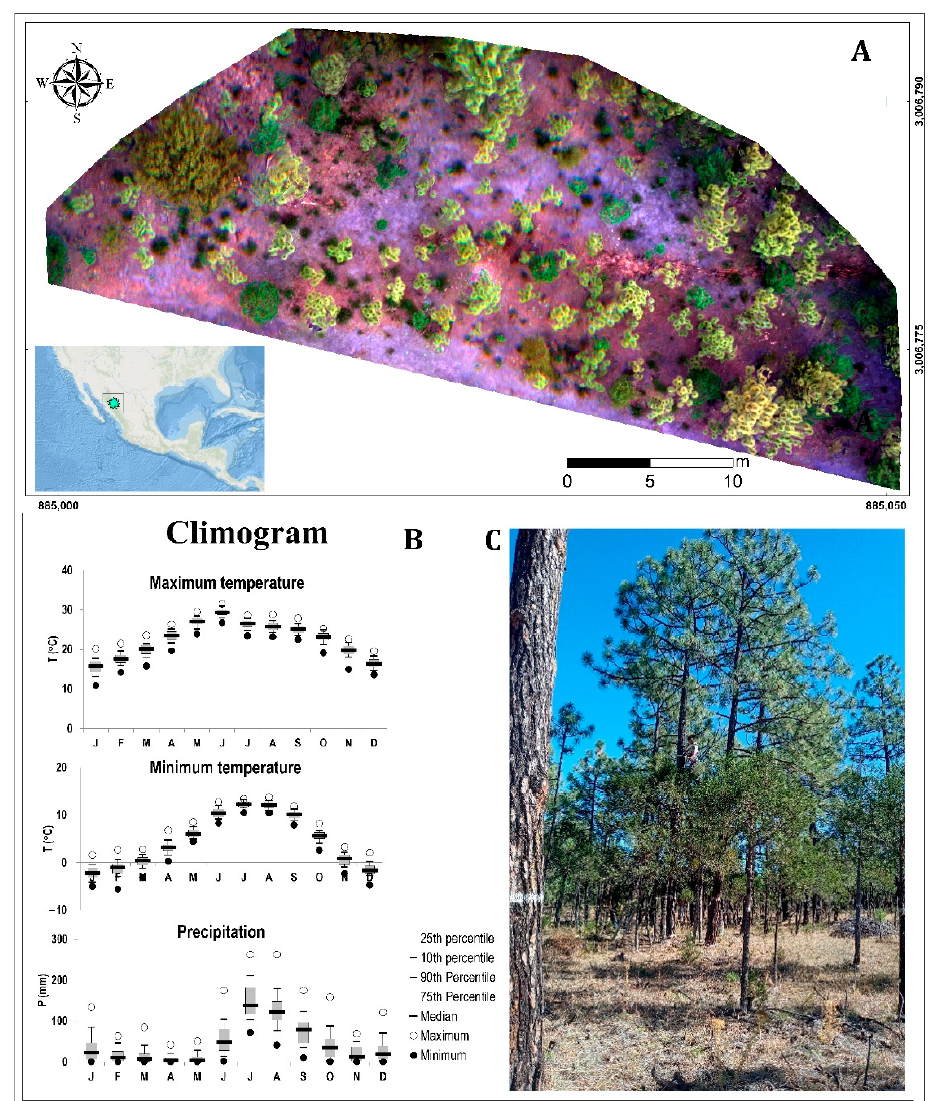
Figure 1. Location and view of Mesa del Pawiranachi ( A ) and climogram of the Papajichi ejido in Chihuahua, Mexico ( B ) and the perspective of site ( C ).